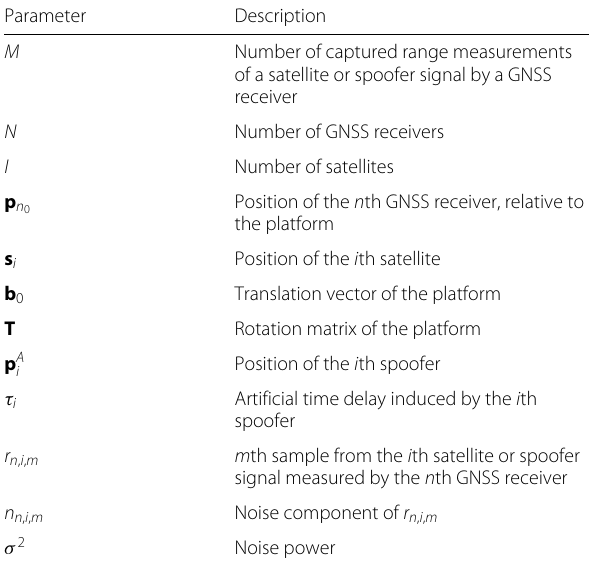
Table 1 Summary of model